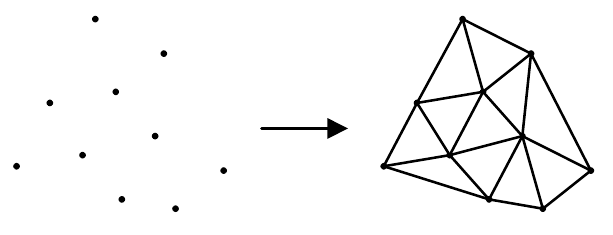
Figure 6. Delaunay triangulation.